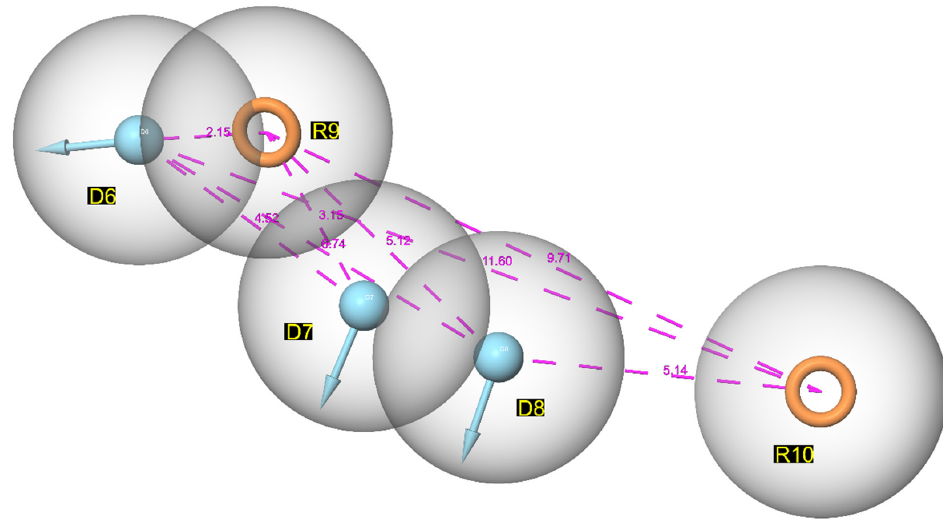
Figure 3. Common pharmacophoric features of generated module (DDDRR_1) with hydrogen bond donor (D) and ring aromaticity (R).